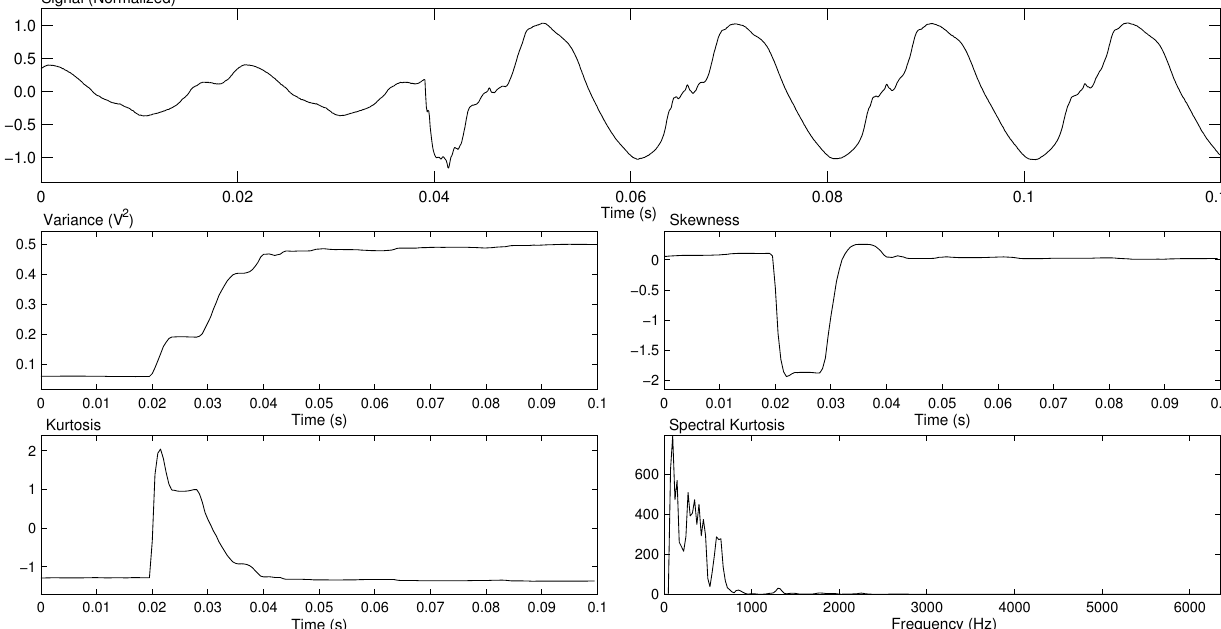
Figure 8. SK analysis over a sag with harmonic distortion, with Gaussian additive noise with σ = 0 . 05 . If harmonics at 25 and 75 Hz are present and there is no sag, two “clean” spectral lines would appear. In the case of a hybrid event, the SK outlines the spectral leakage around the harmonic